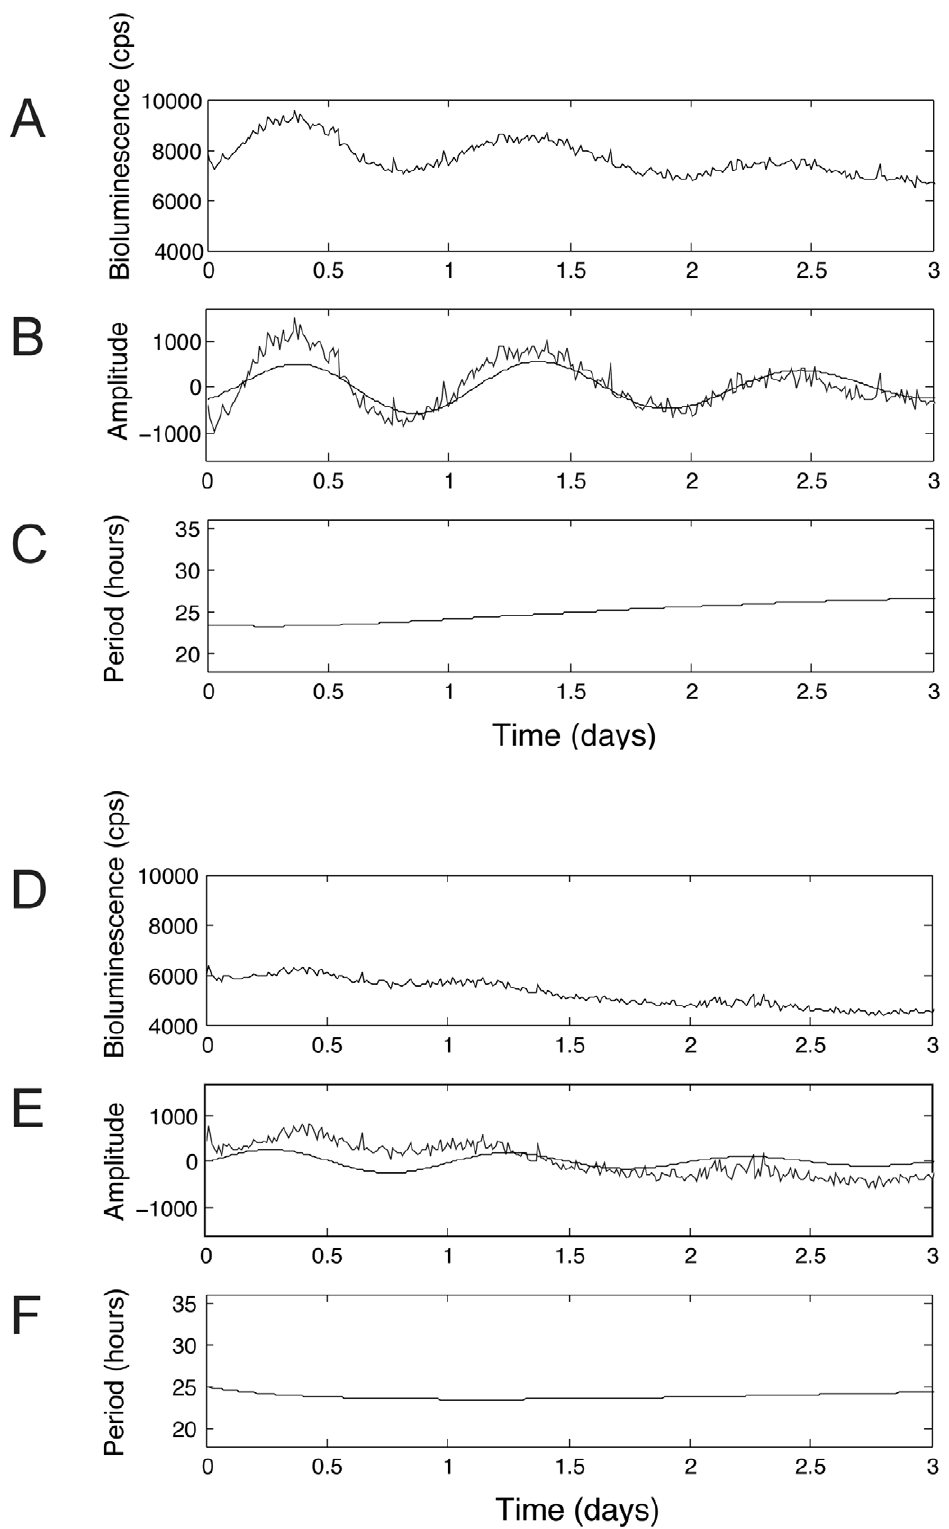
Figure 1. Representative mPER2::LUC bioluminescence profiles, illustrating methods for period estimation from neonatal SCN explants. (A) Representative example of a raw bioluminescence profile fulfilling the stringent criteria, which led to selection of 124 out of 235 mPER2::LUC bioluminescence profiles. (B) Extracted circadian amplitude (black sinusoidal line) along with the linear detrended representation (jagged black line) of the raw data shown in (A). (C) Period estimation from data shown in (A). (D) Representative example of a raw bioluminescence profile that was excluded using the stringent criteria. (E) Extracted circadian amplitude (black sinusoidal line) along with the linear detrended representation